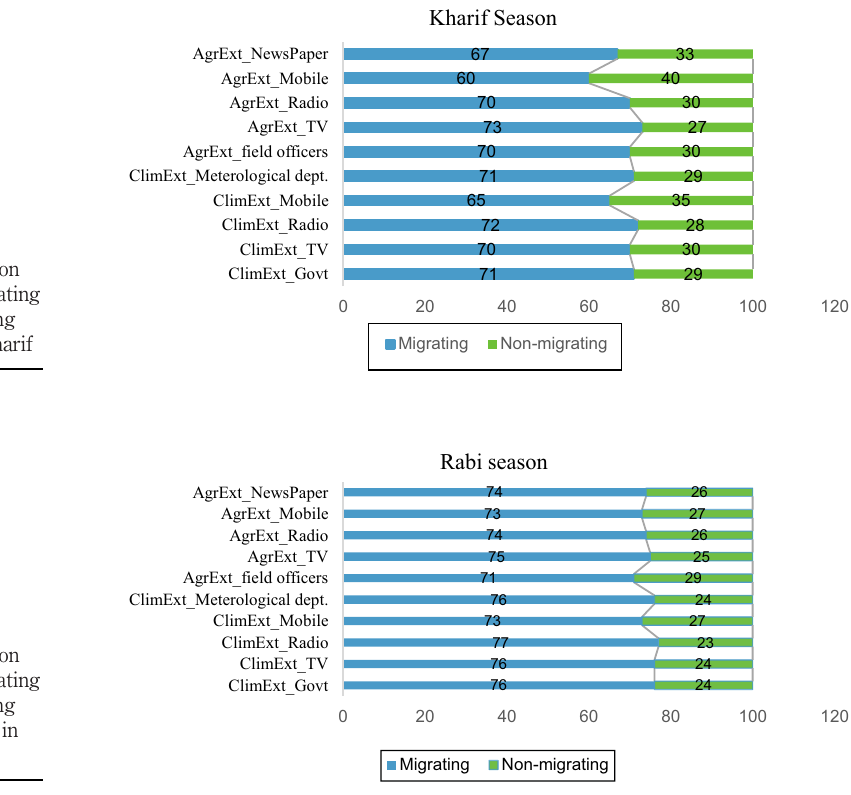
Figure 2. Choice of extension services by migrating and